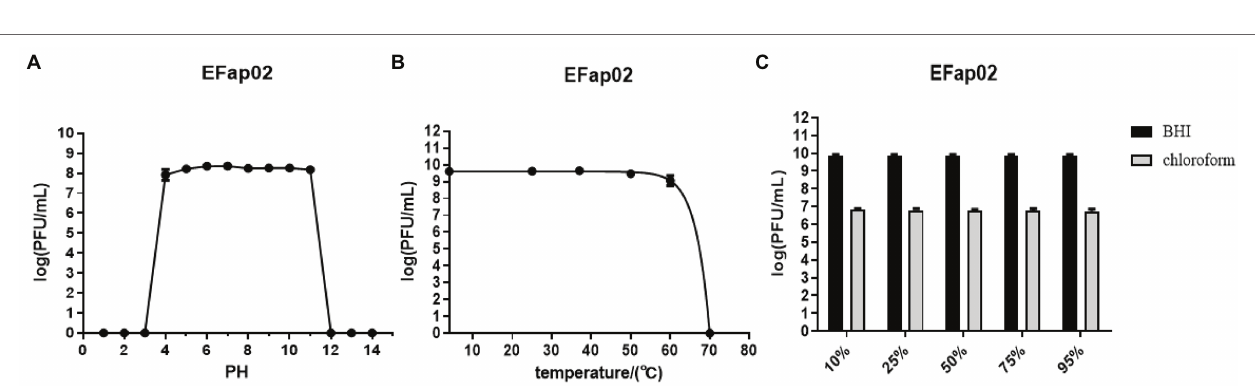
FIGURE 2 | Stability of EFap02 under different conditions. (A) EFap02 is stable over a broad range of pH values (pH values from 4 to 11). (B) EFap02 is viable over a broad range of temperatures. (C) EFap02 is sensitive to chloroform, and the titer drops to approximately 5 × 10 6 PFU/ml after